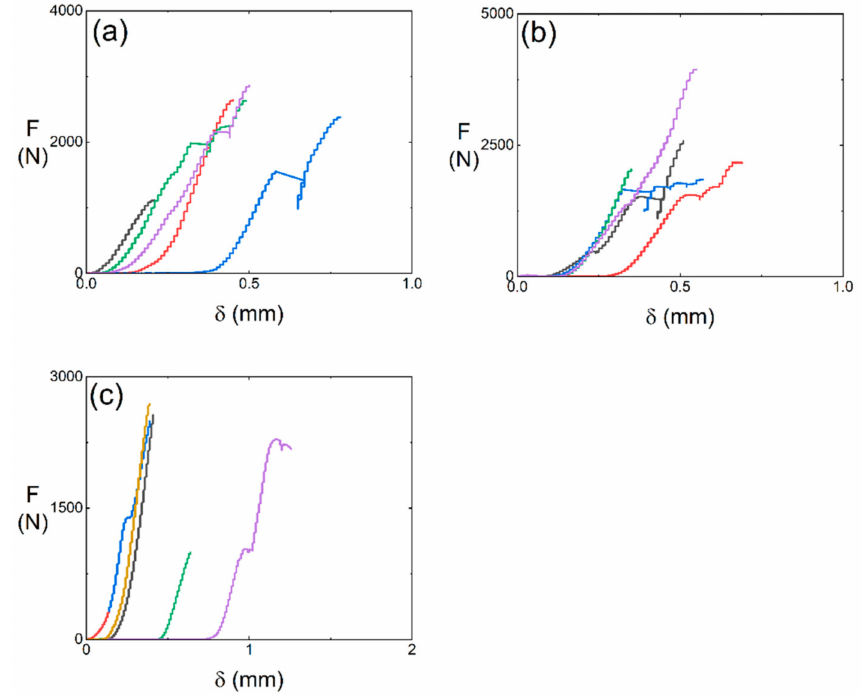
Figure 6. Double-shear load-displacement curves of the 12k T-700 TM MWK–N–C/SiC pins: ( a ) type I; ( b ) type II; and ( c ) type III.